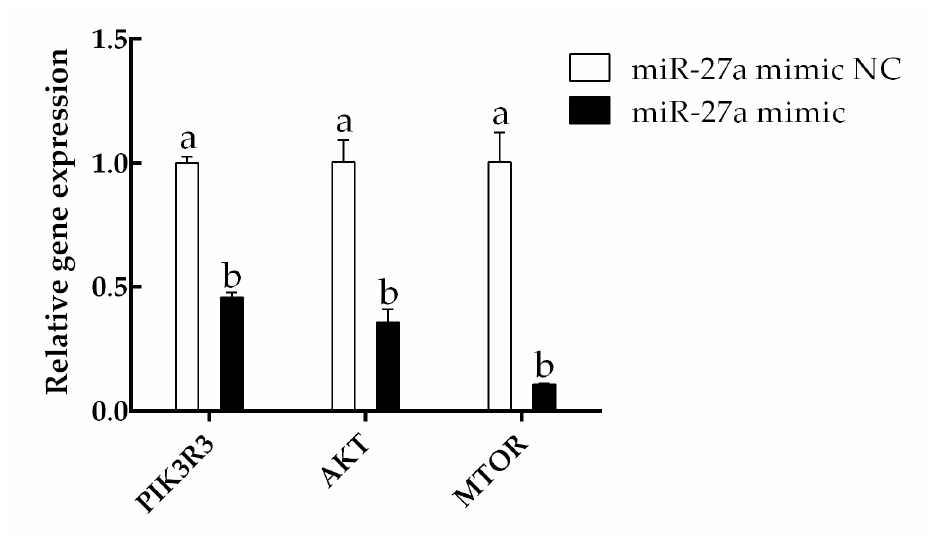
Figure 6. An miR-27a mimic decreases the expression of PIK3R3 , AKT , and MTOR . HFSCs were transfected with the noted siRNAs, and gene expression was determined by RT-qPCR. The different small letters (a, b) in the same graph indicate that the difference between groups is statistically significant ( p < 0.05).